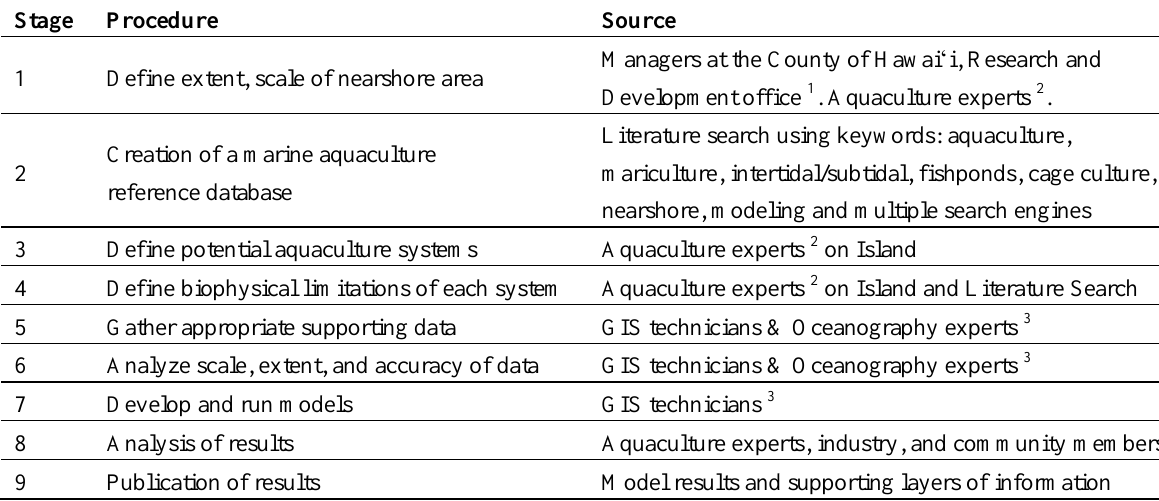
Table 1. Stages of model development. Procedures and personnel used to identify potential sites for nearshore